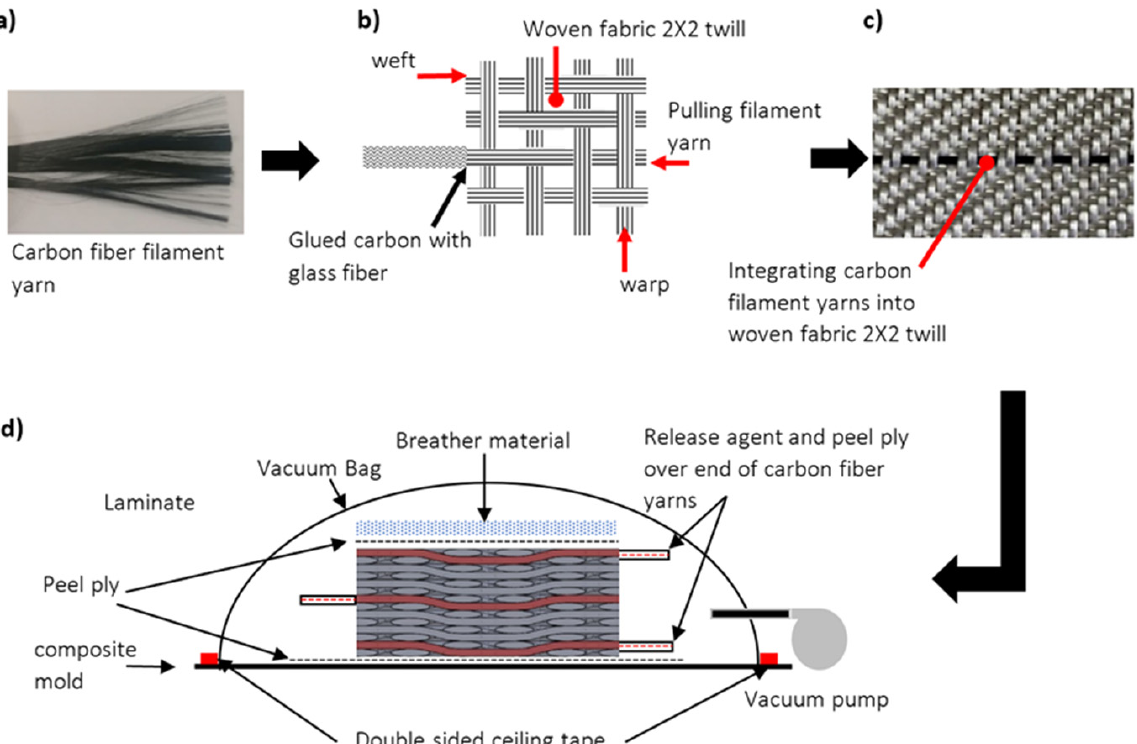
Table 1. Electrical and mechanical properties. (*) Indicates properties value of the weft direction.